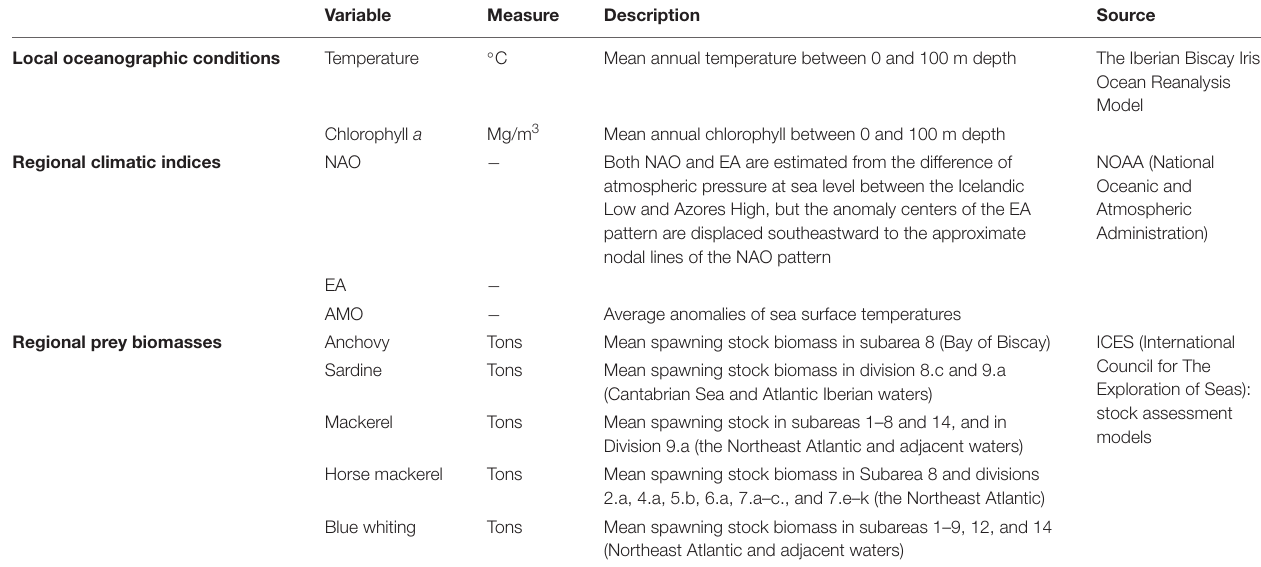
TABLE 1 | Summary of the local oceanographic, regional climatic and regional prey variables used in this study accompanied by a little description and the source from which they were